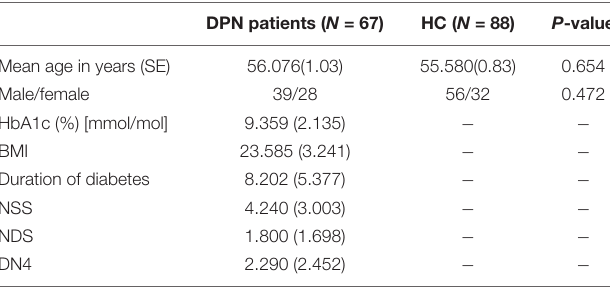
TABLE 1 | Demographic data of the